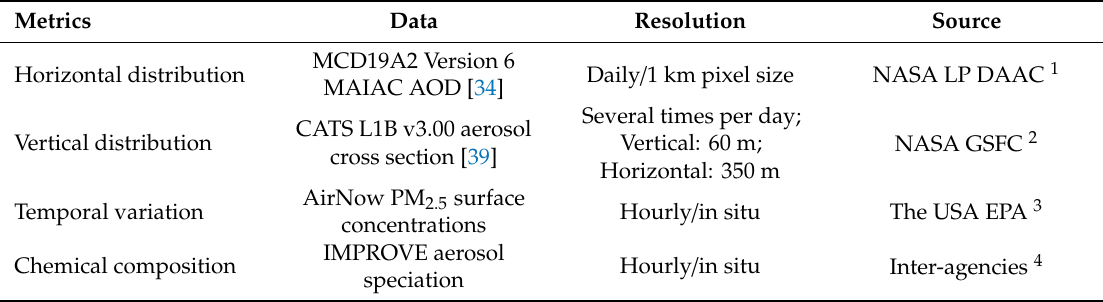
Table 2. The observational datasets used for the model performance